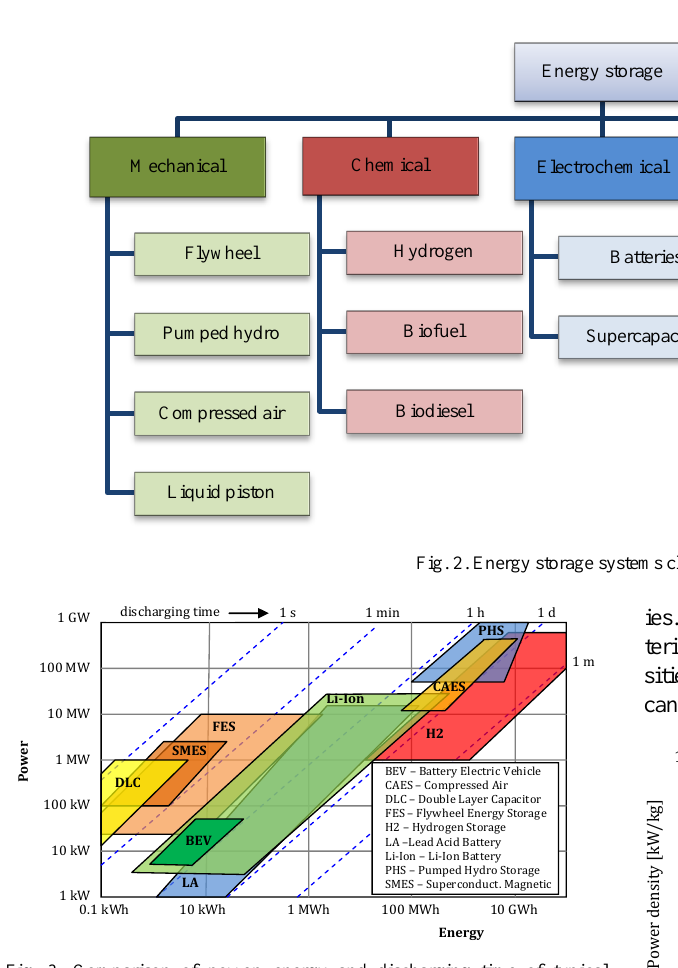
Fig. 3. Comparison of power, energy and discharging time of typical energy storage systems [10]